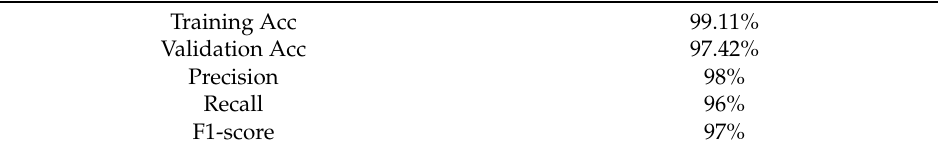
Table 4. FIA Table 4. FIA performance.